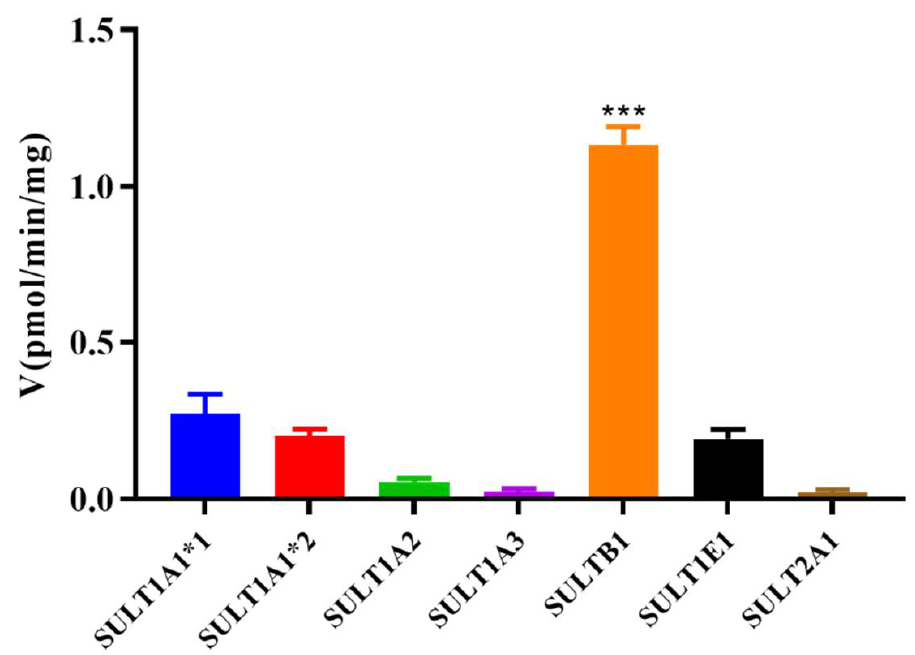
Figure 4. Identification of the major SULT enzymes responsible for the sulfation of magnolol. Formation rate of magnolol sulfated metabolite in the incubation of magnolol (25 µM) with seven recombinant human SULT isoforms (0.05 mg protein/mL). It was calculated and expressed as a nanomole per minute per milligram of protein for sulfation rates. *** p < 0.001 vs other group. Each point is the average of three determinations, and the error bar is the standard deviation of the mean.